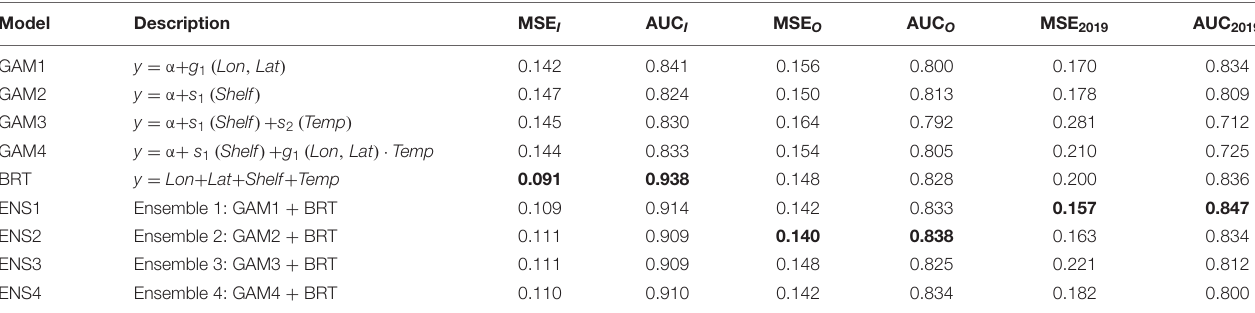
TABLE 2 | Summary of forecast model performance.